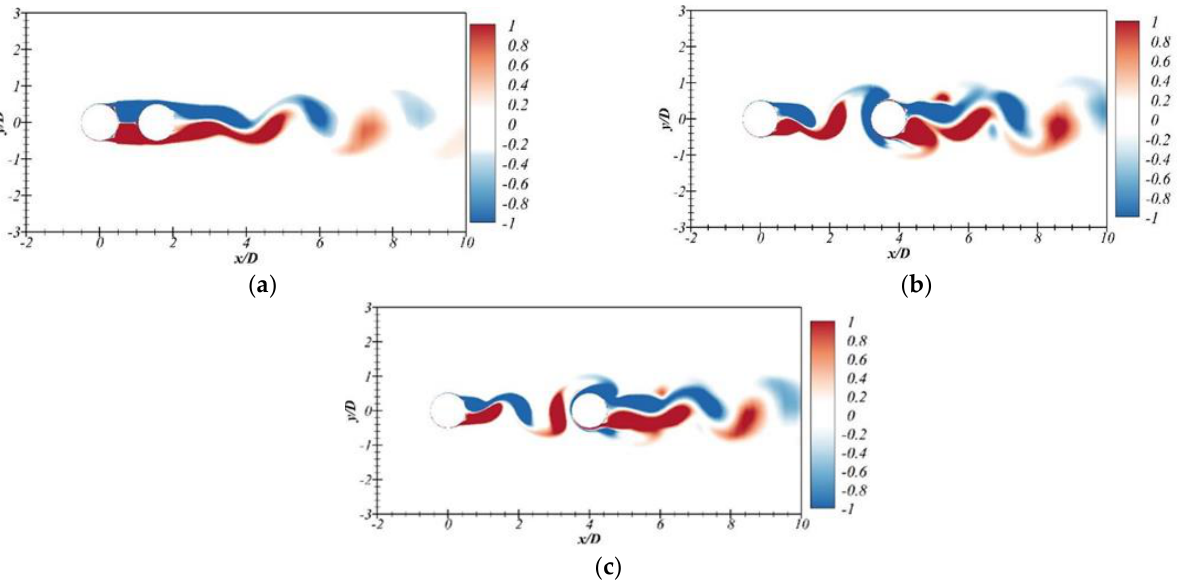
Figure 7. Instantaneous contours of the spanwise vorticity for ( a ) 𝐿/𝐷 = 1.56 ; ( b ) 𝐿/𝐷 = 3.7 ; ( c ) 𝐿/𝐷 = 4 .